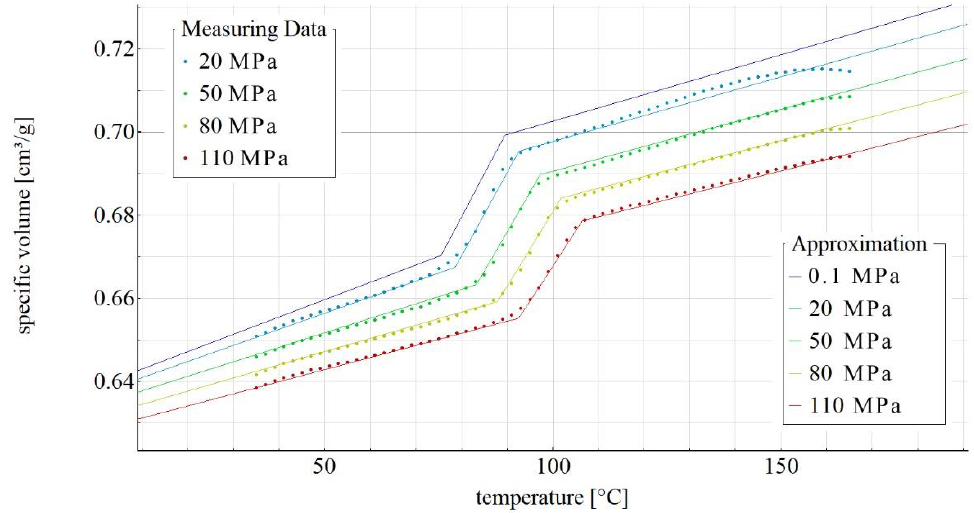
Figure 4. p-v-T diagram for polybutylene succinate containing 30% by weight of ground wheat bran.